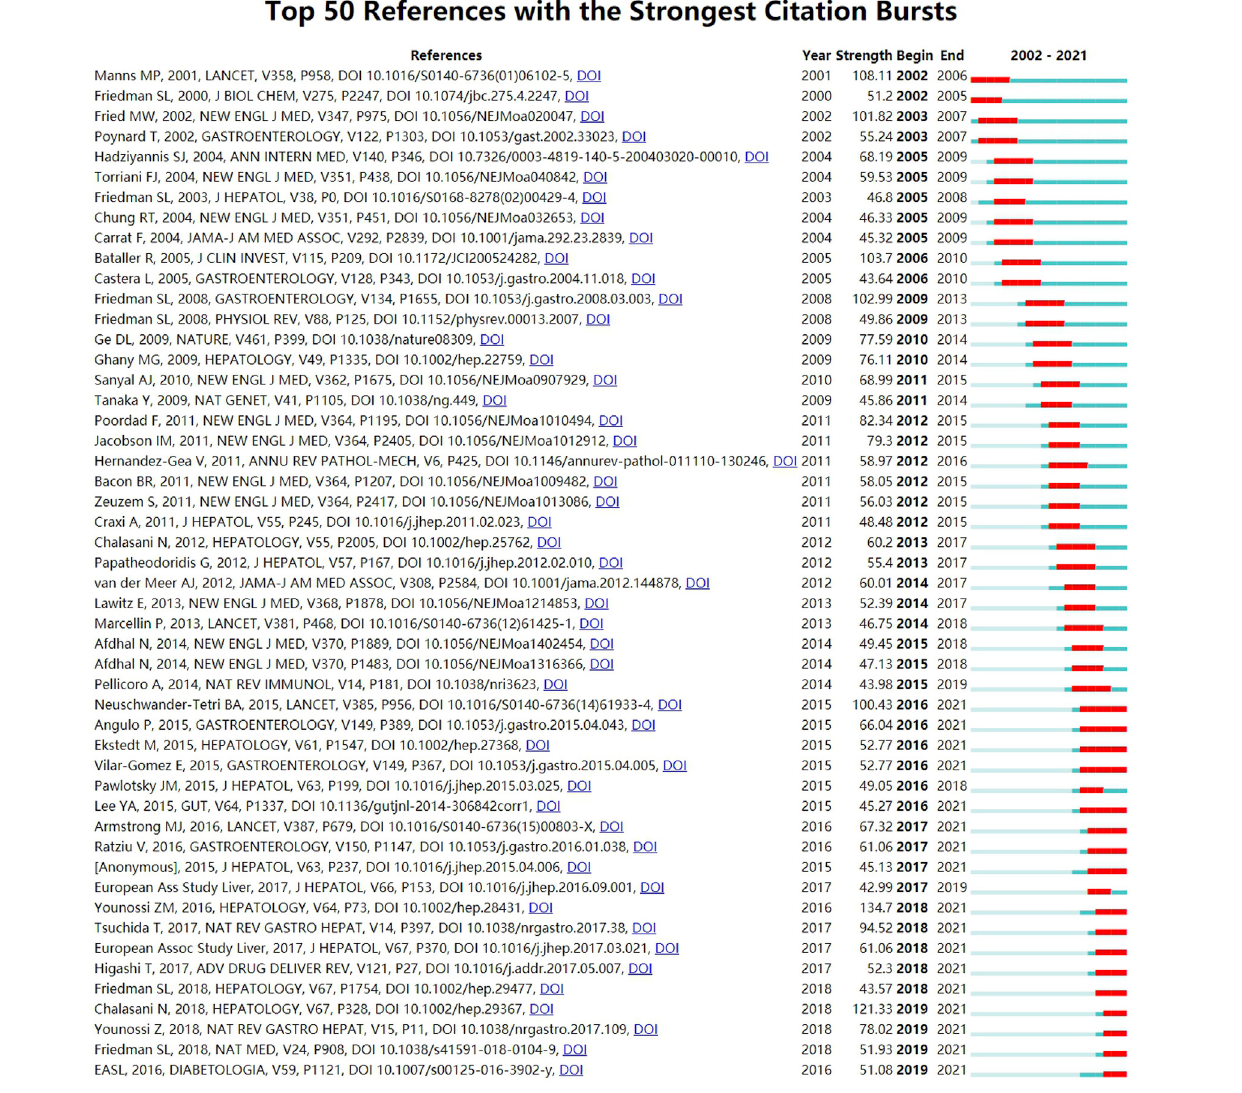
Frontiers in Pharmacology |